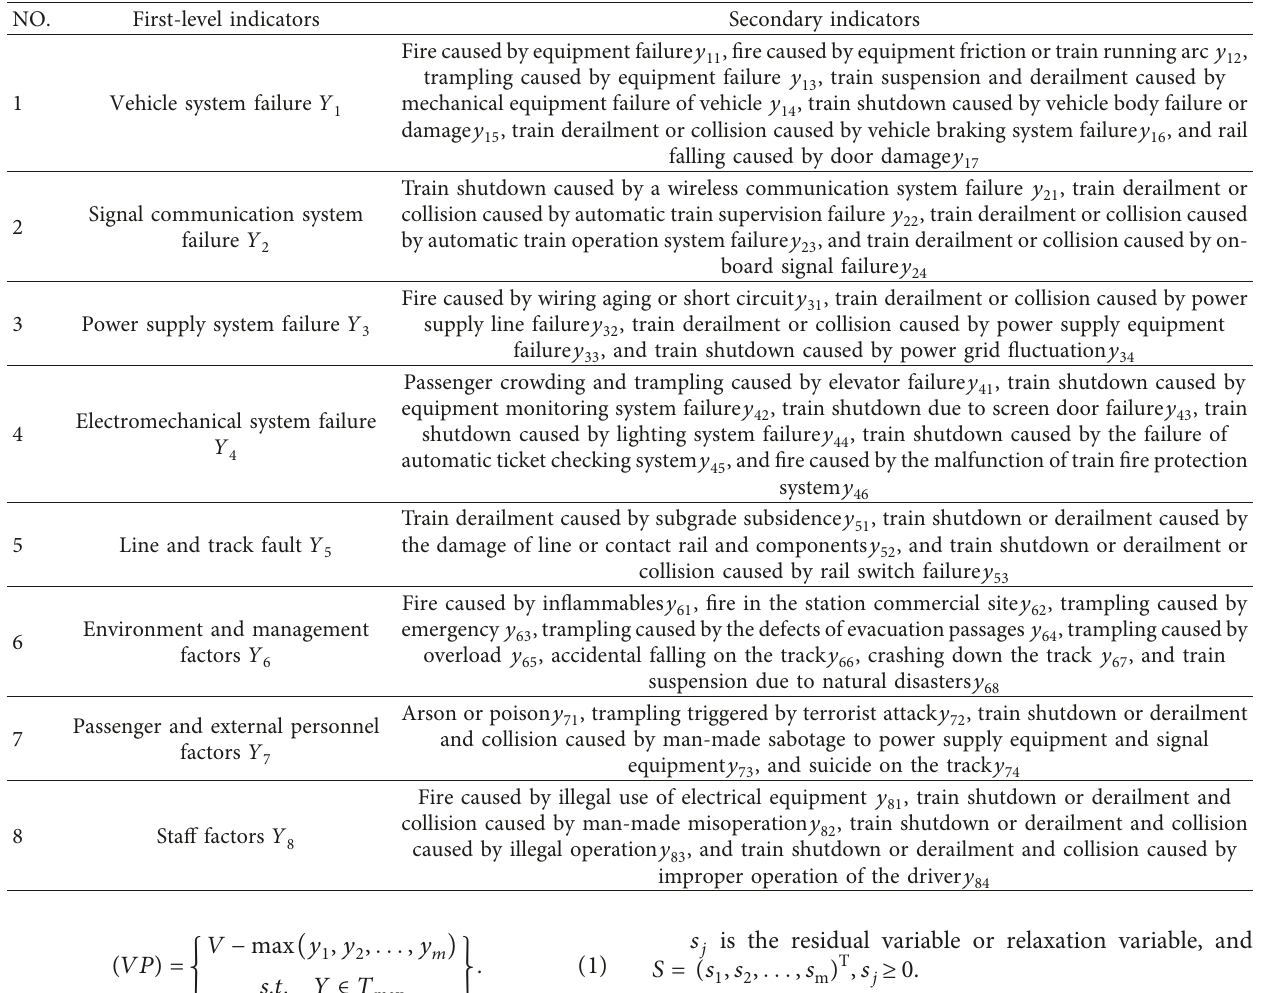
Table 1: Index system of rail transit operation